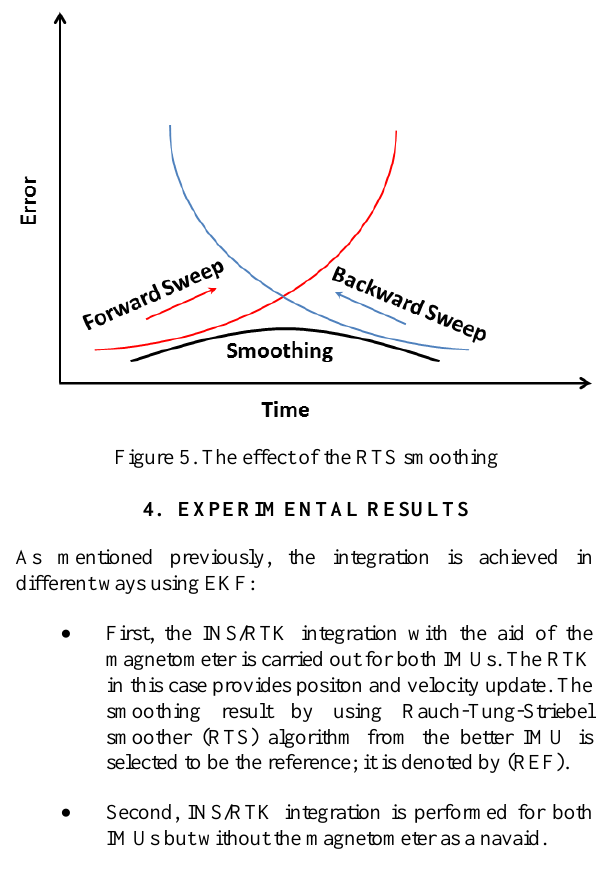
Figure 5. The aim of RTS smoother is to enhance the accuracy.